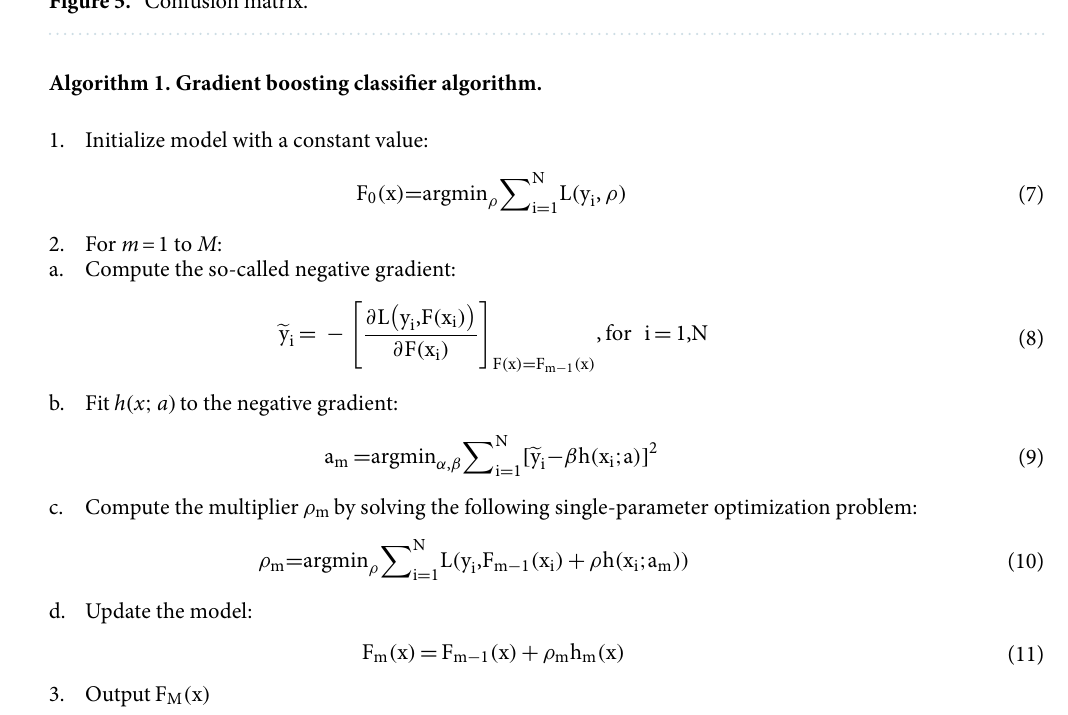
Figure 5. Confusion